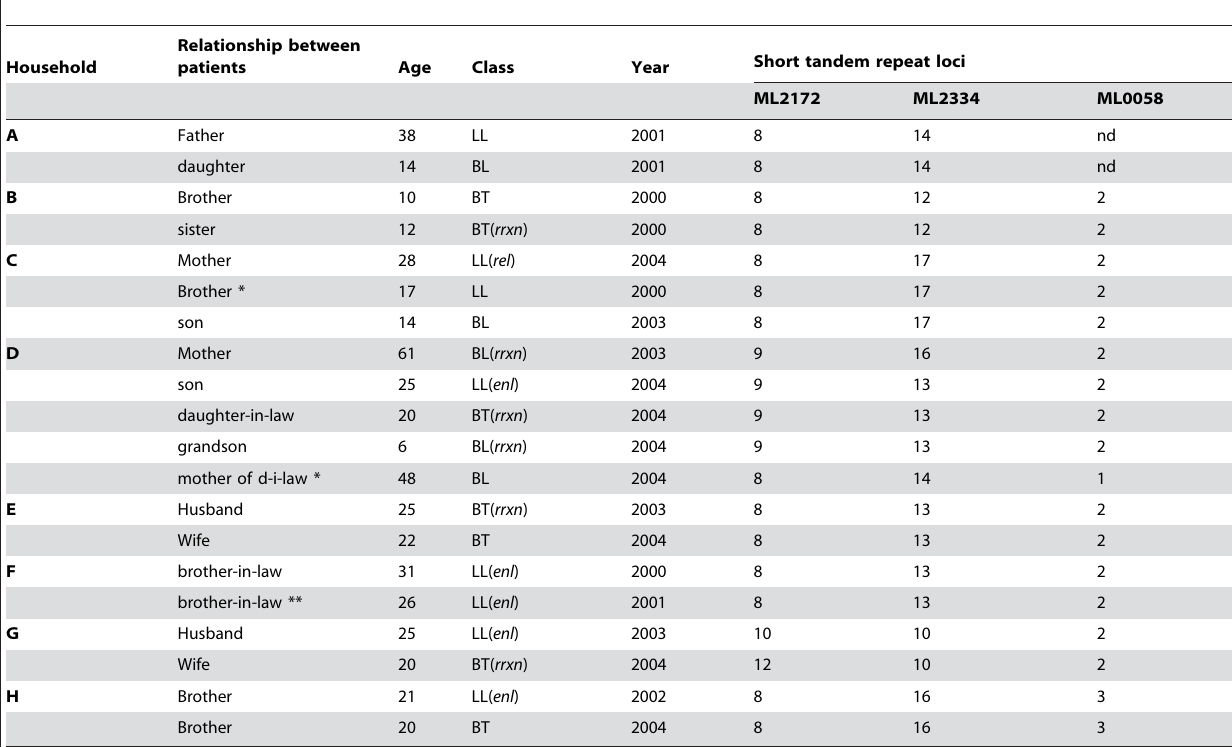
Table 6. Comparison of copy numbers of short tandem repeat loci in biopsies from patients in multicase families in India.